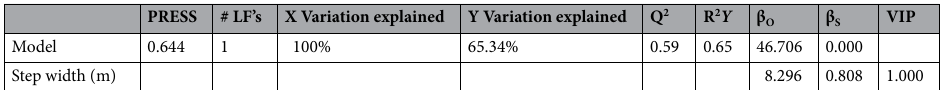
Table 6. Results of the partial least squares model for the ML MoS in HCs. ML MoS: Medio-lateral margin of stability; PRESS: Predictive Residual Sum of Squares; # LF’s: number of Latent Factors; Q 2 : goodness of prediction; R 2 Y : goodness of fit; β O : regression coefficient for original data; β S : regression coefficient for centred and scaled data; VIP: Variable Importance in Projection; m: